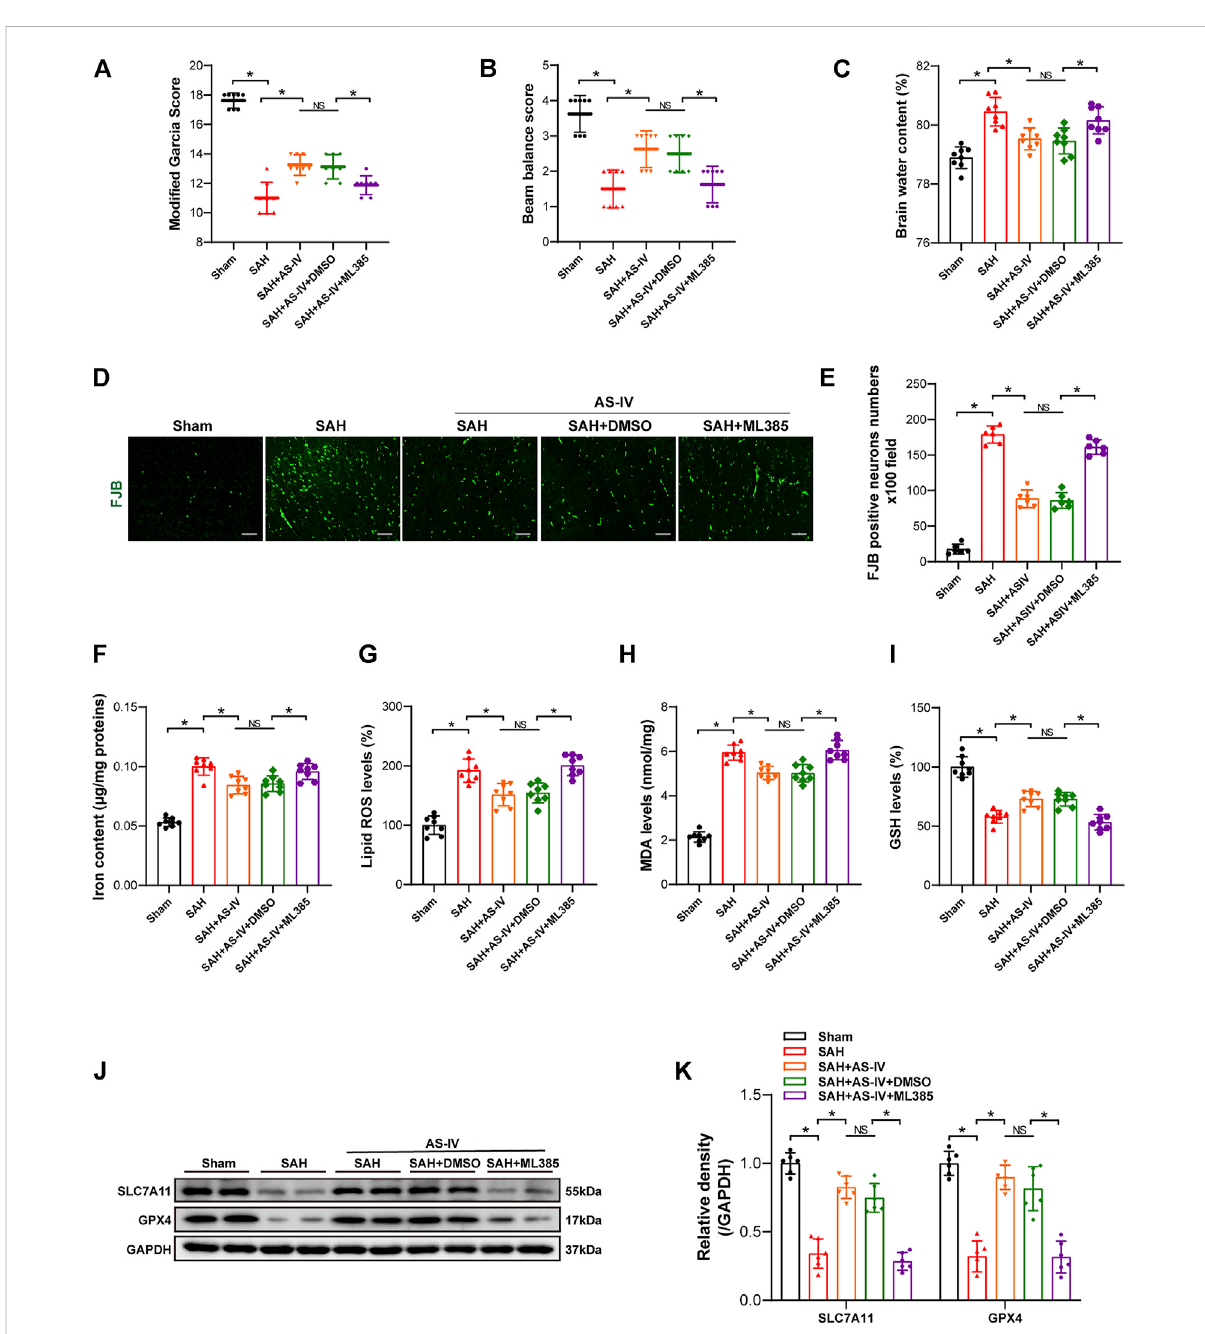
FIGURE 5 ML385 inhibits the neuroprotective effect of AS-IV at 24 h post-SAH. (A – C) Modi fi ed Garcia scores, beam balance scores, and brain water content24 hafterSAHinrats( n =8). (D,E) RepresentativeimagesandquantitativeanalysisofFJBstaininginrighttemporalcerebralcortexofrats(n= 6, scale bar = 50 μ m). (F) Quanti fi cation of iron concentrations in rats after SAH ( n = 8). (G – I) Quantitative analysis of lipid ROS, MDA, and GSH levels ( n = 8). (J) Representative Western blot images of SLC7A11 and GPX4. (K) Quantitative analysis of SLC7A11 and GPX4 ( n = 6). Data are represented as mean ± SD. * p < 0.05, NS: not statistically signi fi cant; DMSO: dimethyl sulfoxide; FJB, Fluoro-Jade B